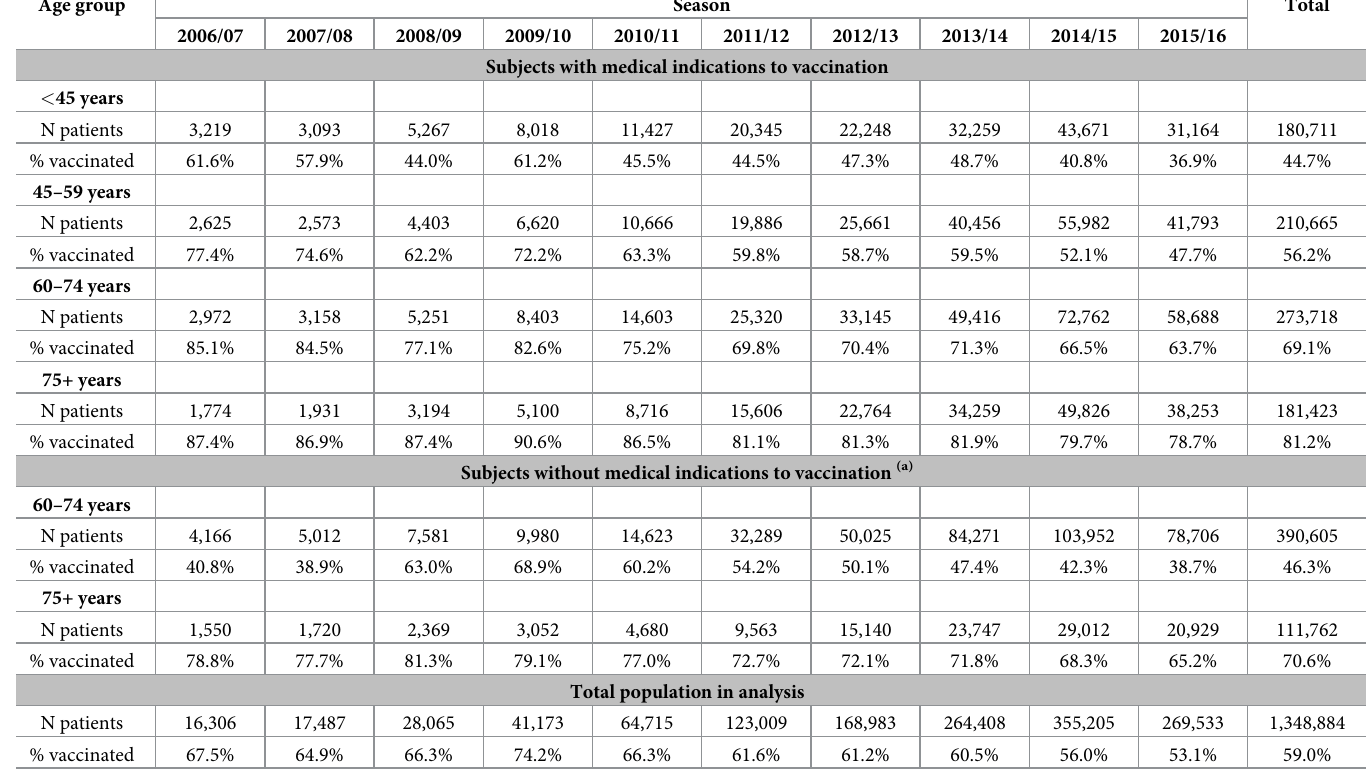
Table 2. Study subjects (denominators), and proportion of those who were vaccinated, in each season and overall, according to the subjects’ age and presence of a medical indication to vaccinate. Netherlands, 2006/07 to